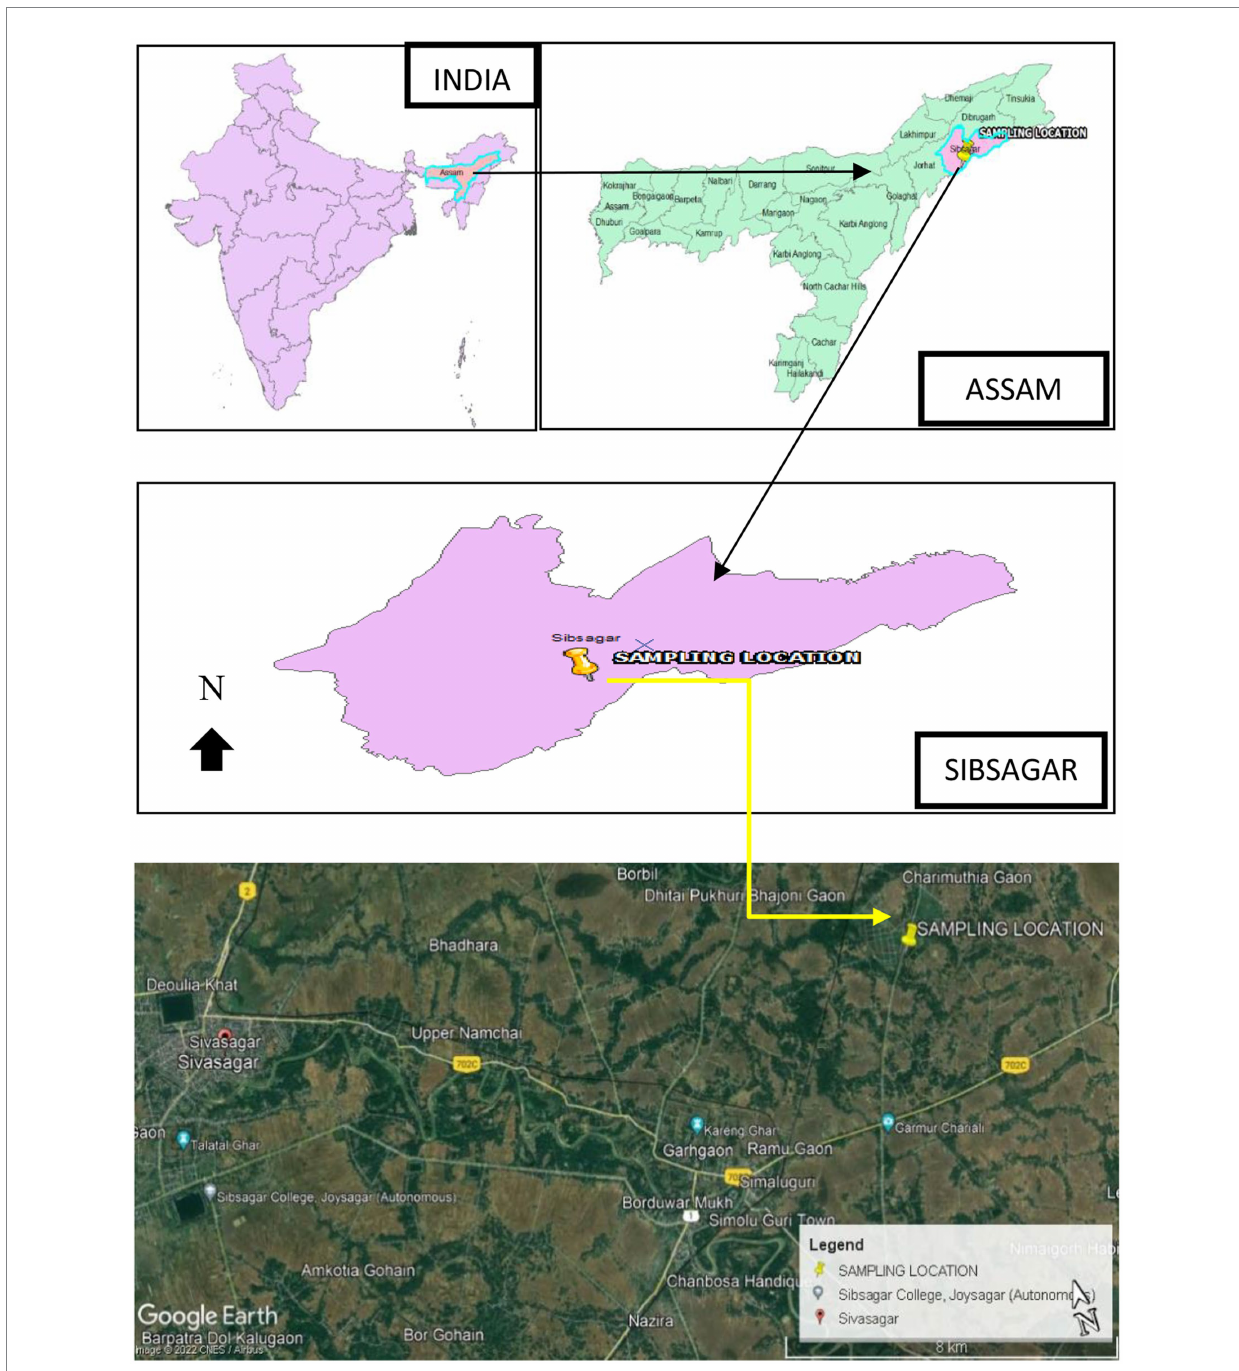
FIGURE 1 The sample collection site, Sivasagar District,